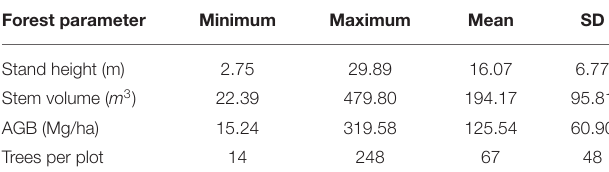
TABLE 1 | Summary of forest parameter statistics collected during field campaigns (SD represents standard deviation).